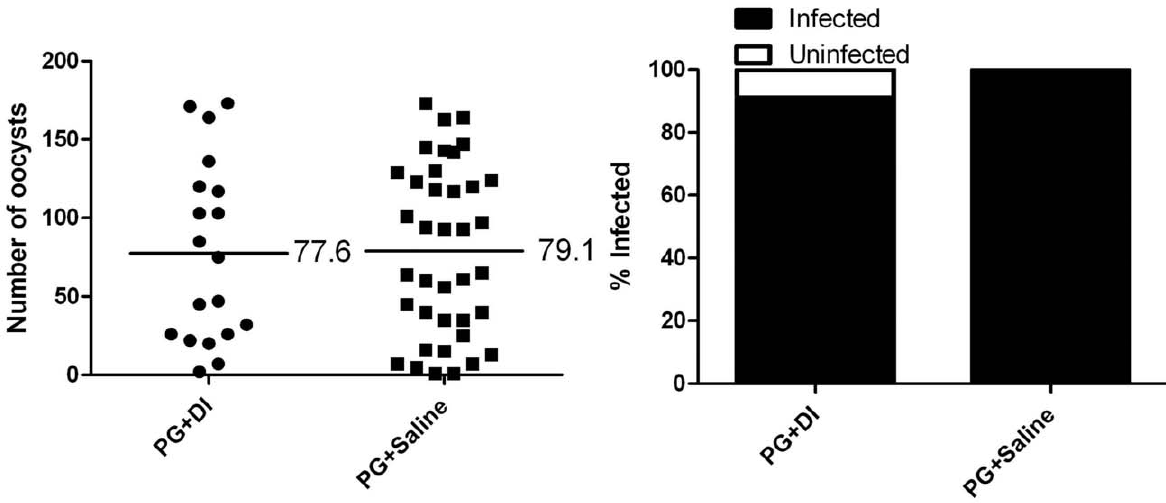
Figure 2. Plasmodium infection in mosquitoes inoculated with D.immitis mf immediately following blood feeding. Mosquitoes that fed on blood containing P. gallinaceum and received a saline inoculation immediately following blood feeding served as controls. There was no significant difference in Plasmodium development between mosquitoes that were exposed to P. gallinaceum and intrathoracic injection of saline (n=38) or mosquitoes exposed to P. gallinaceum and intrathoracic injection of D. immitis mf (n=21). The left panel indicates infection intensity where points indicate the absolute value of oocyst counts in individual mosquitoes, and horizontal black bars represent the mean intensity. The right panel indicates prevalence of infection where the bars represent the total population of mosquitoes examined. The filled portion of the bars indicates the proportion of mosquito midguts that were positive for at least one oocyst; the unfilled portion of the bar indicates the proportion of midguts that were uninfected. PG, P. gallinaceum; DI, D. immitis.